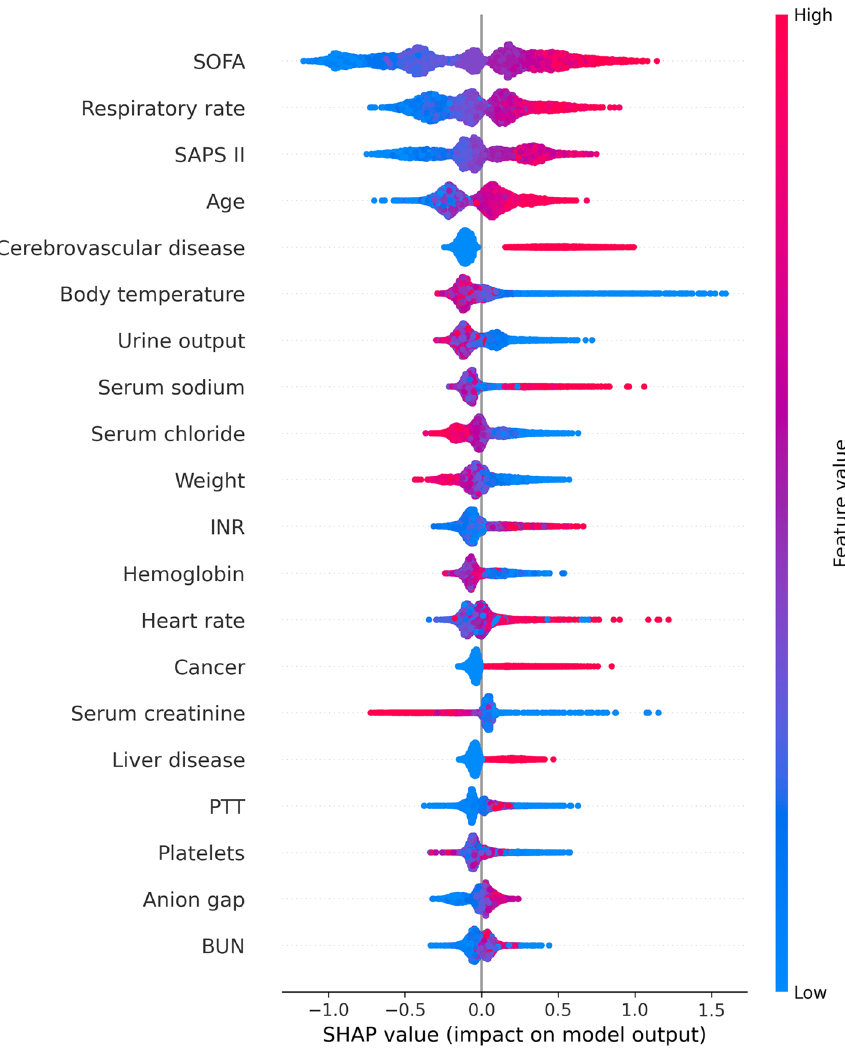
Figure 4. SHAP summary plot of the top 20 features of the XGBoost model. The greater the SHAP value of a characteristic, the greater the likelihood of death development. The abscissa represents the SHAP value, and each line represents a feature. Red dots indicate greater feature values, whereas blue dots indicate lower feature values. SHAP SHapley additive explanation, SOFA Sequential organ failure assessment, SAPS II Simplified acute physiology score II, INR International normalized ratio, PTT Partial thromboplastin time, BUN Blood urea